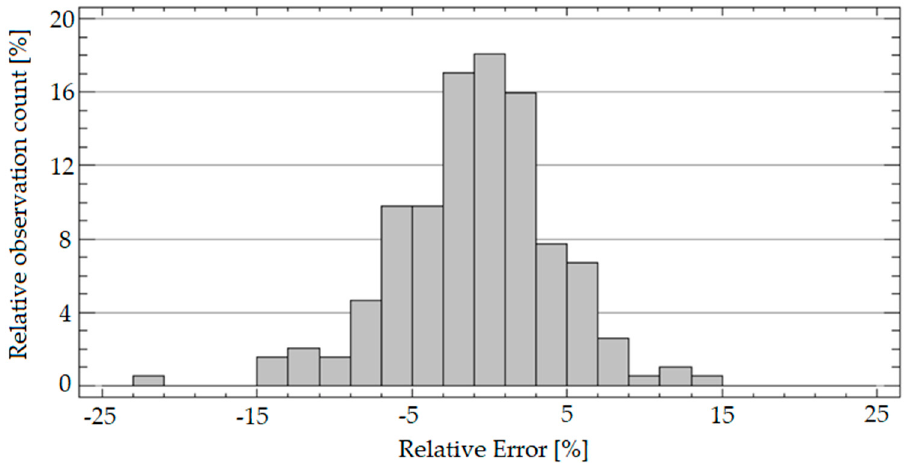
Figure 7. The relative error Figure 8. The relative error distribution.